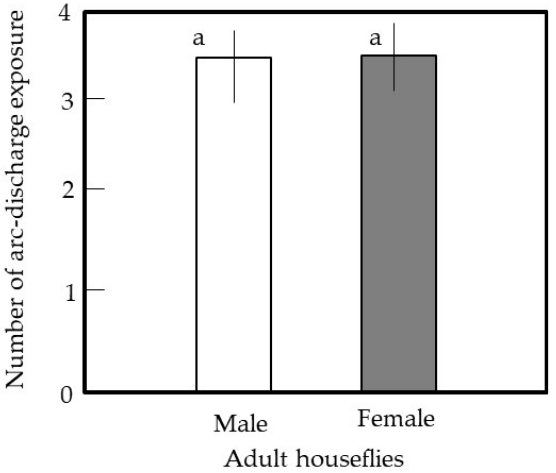
Figure 9. Assay of the preferential attraction of whiteflies to a yellow-colored electrostatic insect catcher (Y-EIC), a yellow sticky trap (YST), and a potted tomato seedling (P-TS), which were placed in concyclic positions at equal distances. A vessel containing test insects was placed at the central position of a circle. Adult whiteflies were used as test insects. In all experiments, the destinations of test insects were recorded 1 day (open) and 2 days (gray column) after their release. OTS represents other places, such as in the vial or on the floor, wall, and ceiling of the cabinet. Twenty insects were used in each experiment, and the means and standard deviations were calculated from five replicates of the experiments. The letters a–c in each vertical column indicate significant differences ( p < 0.05) according to Tukey’s test.